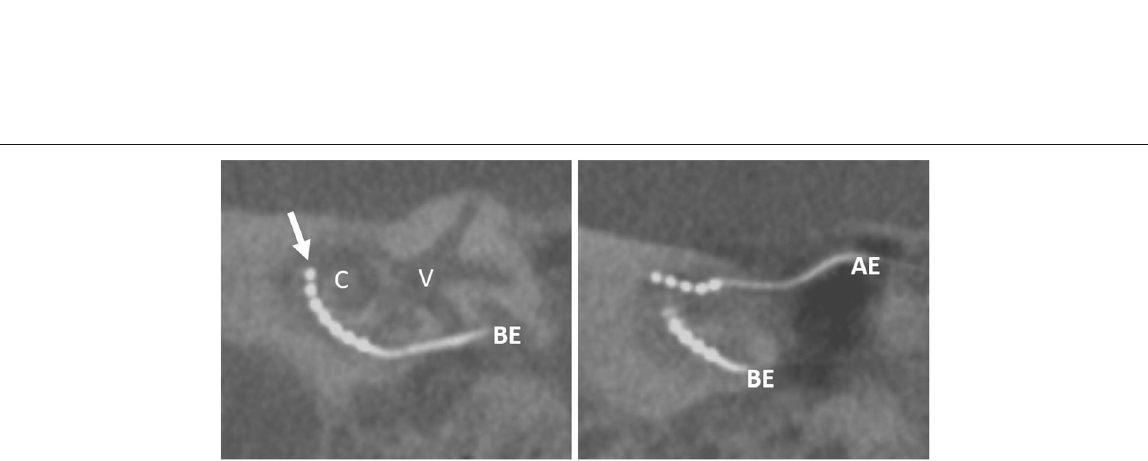
Fig. 21 A 70-year-old male patient, with normal postoperative finding after split electrode surgery due to far advanced otosclerosis. CBCT paracoronal image (left) shows basal electrode (BE) with the tip up to the first half of the basal turn (arrow). CBCT paraaxial maximum intensity projection image shows the additional apical electrode (AE) in the middle turn. C – cochlea. V – vestibulum